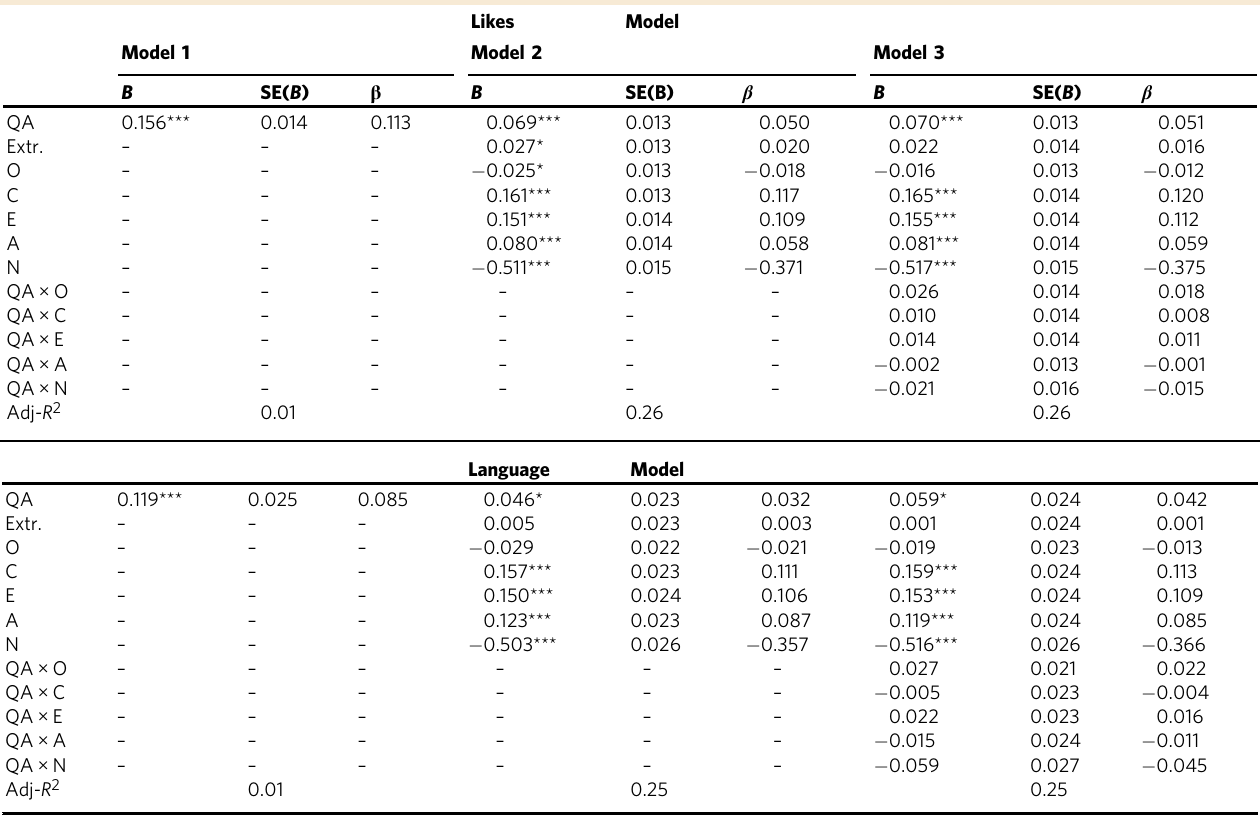
Table 1 Regression analysis of Life Satisfaction on Quanti fi ed